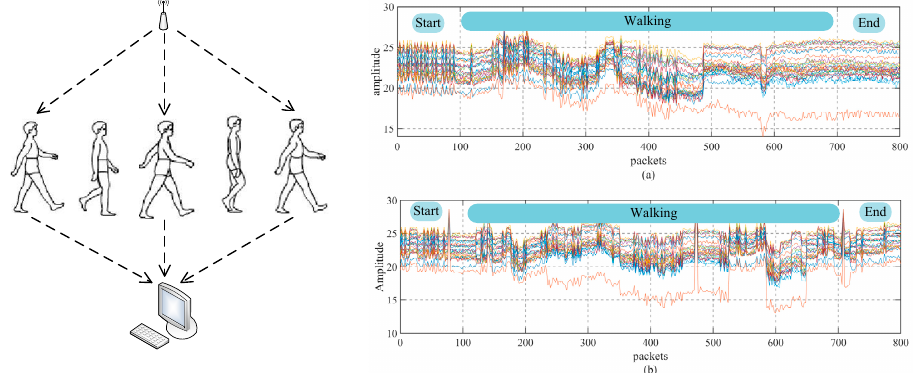
Figure 1. Channel state information (CSI) signal: ( a ) one person walking; ( b ) the other person walking.